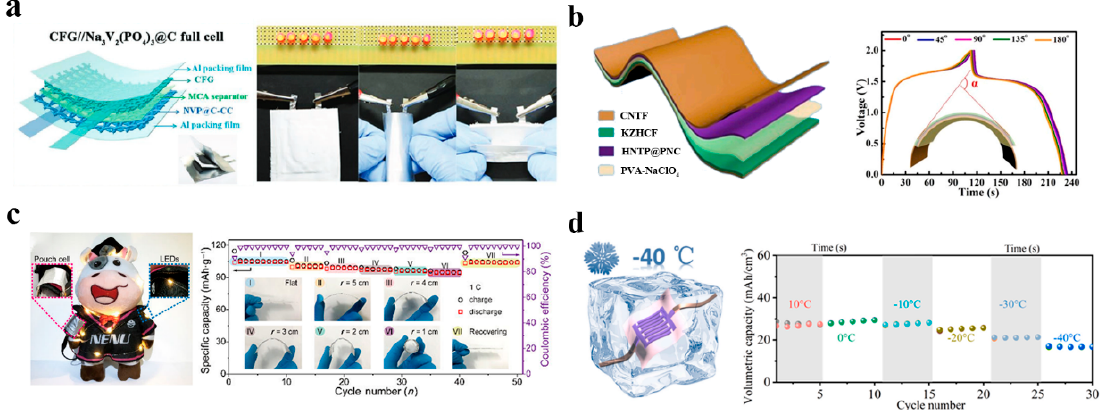
Figure 11. ( a ) Schematic illustration of all-flexible sodium-ion full cell and lighting up LED bulbs for practical use. Reproduced with the permission of ref. [22], 2019 WILEY − VCH Verlag GmbH & Co. KGaA, Weinheim. ( b ) Cycling stability of the flexible quasi − solid − state full at different bending angle condition. Reproduced with the permission of ref. [88], copyright 2021 Elsevier